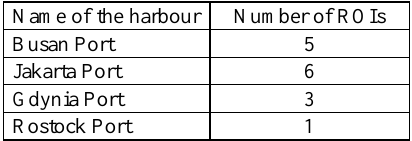
Table 3. Number of ROIs extracted on each image by SIFT- based keypoint matching method